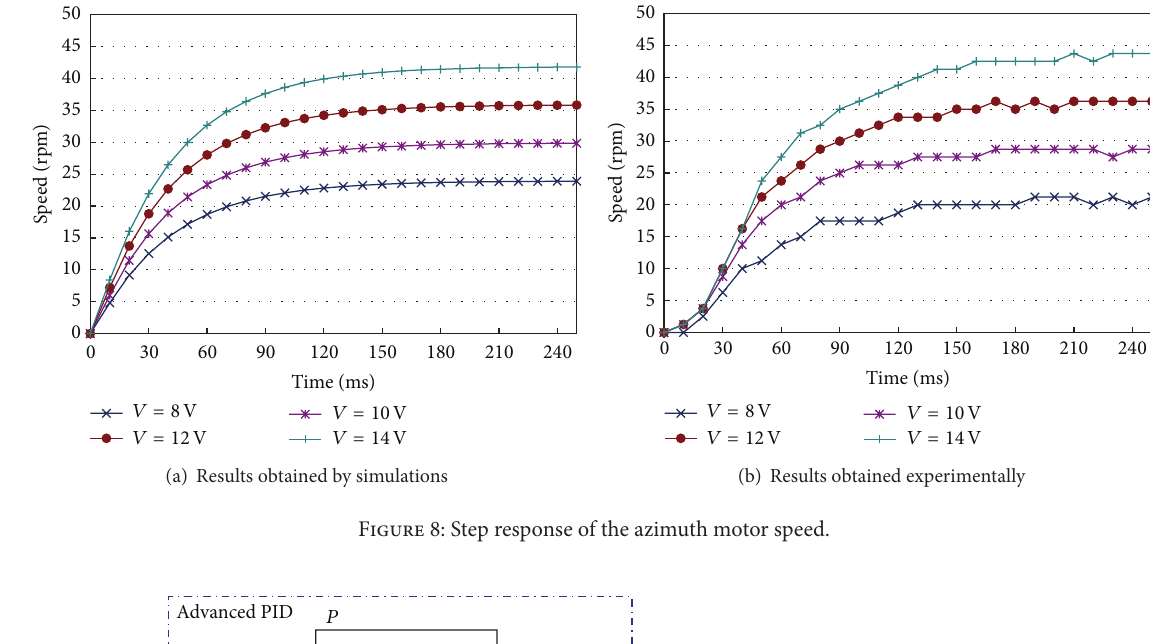
(b) Results obtained experimentally